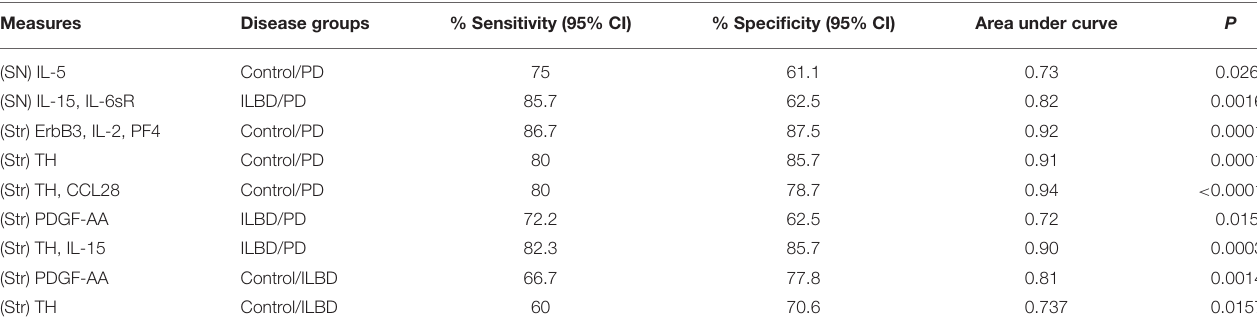
TABLE 4 | Sensitivity and specificity for discriminating between disease